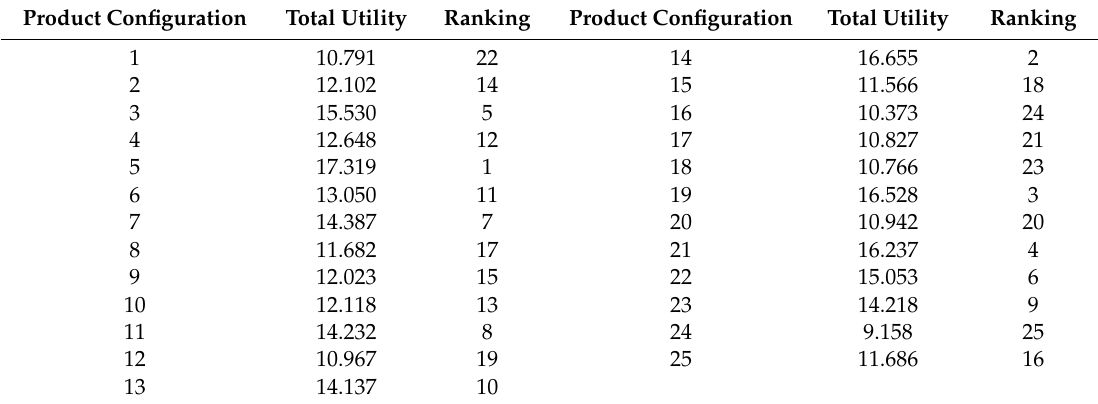
Table 8. Total utility and ranking for each product